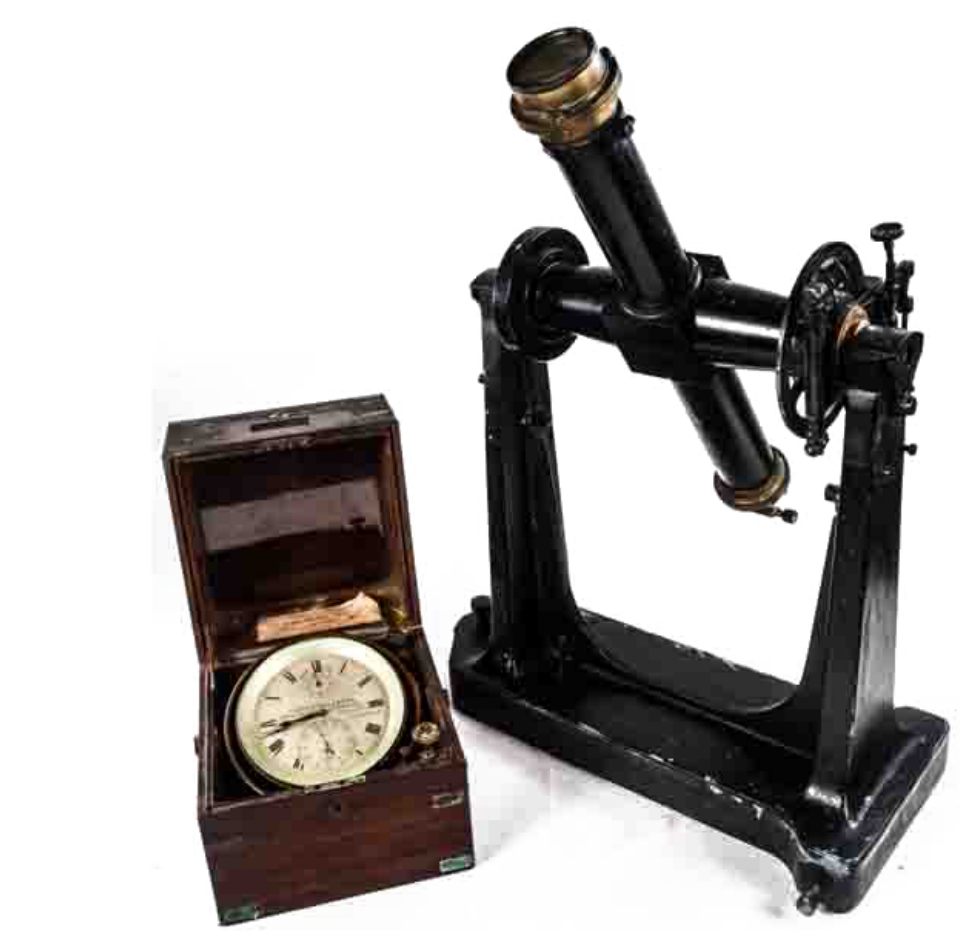
Figure 22. Transit telescope and chronometer (courtesy of Colaba–Alibag